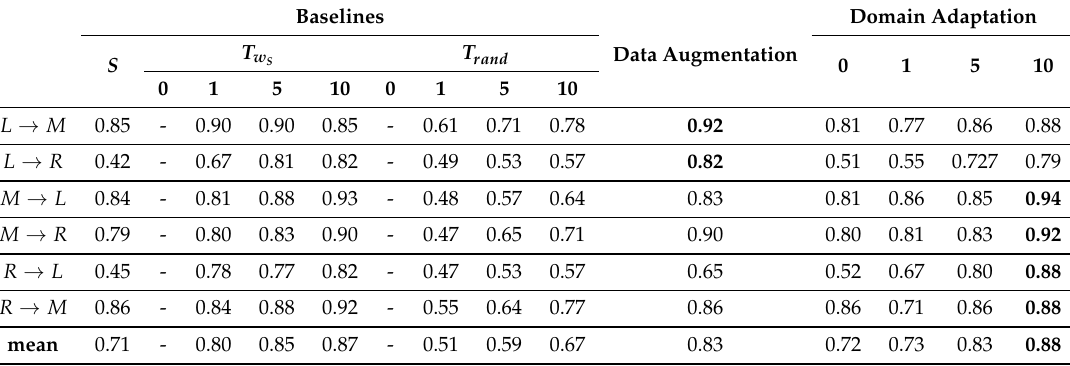
Table 2. Experimental results. Figures represent average F1 scores over ten runs. In each setup best F1 score achieved is indicated with bold. As in Table 1, for each viewpoint adaptation scenario, for example, “Left to Middle” (indicated L → M ) the four numbers (0, 1, 5 and 10) indicate the percentage of target data instances which are labelled. S is the source model, built by a simple cross-view experiment. T rand and T w denote models whose initial weights have been taken randomly and from S , respectively. Note that S with no labeled data in the target domain (i.e., 0) these models cannot be trained and hence these columns are